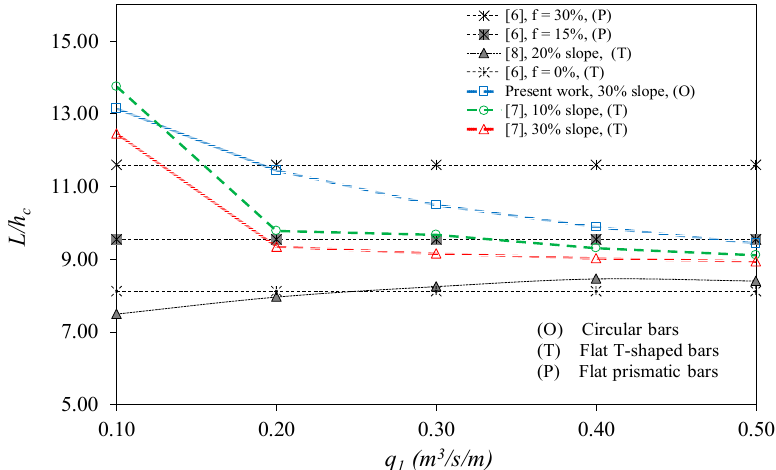
Figure 20. Calculated rack length necessary to derive the total incoming flow when sediment transport is presented for different rack slopes.